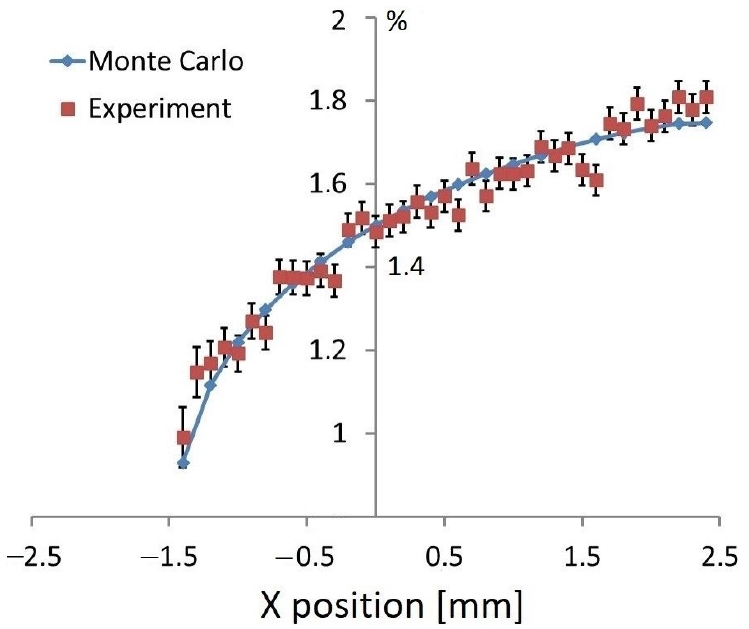
Figure 3. A number of detected photons of Fe and Cr (K α lines).